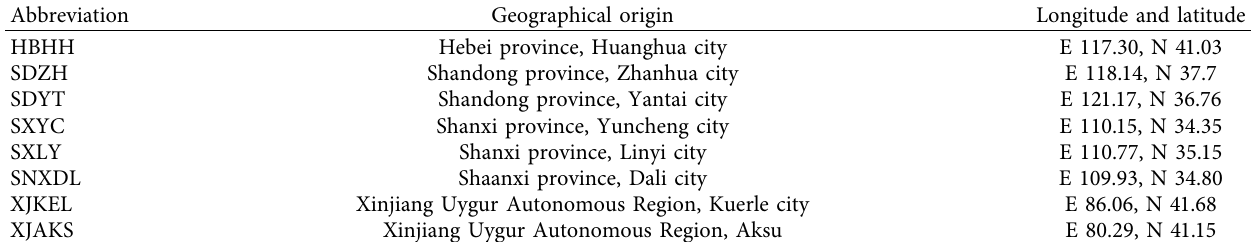
Table 1: Geographical distribution information of winter jujubes from eight regions.